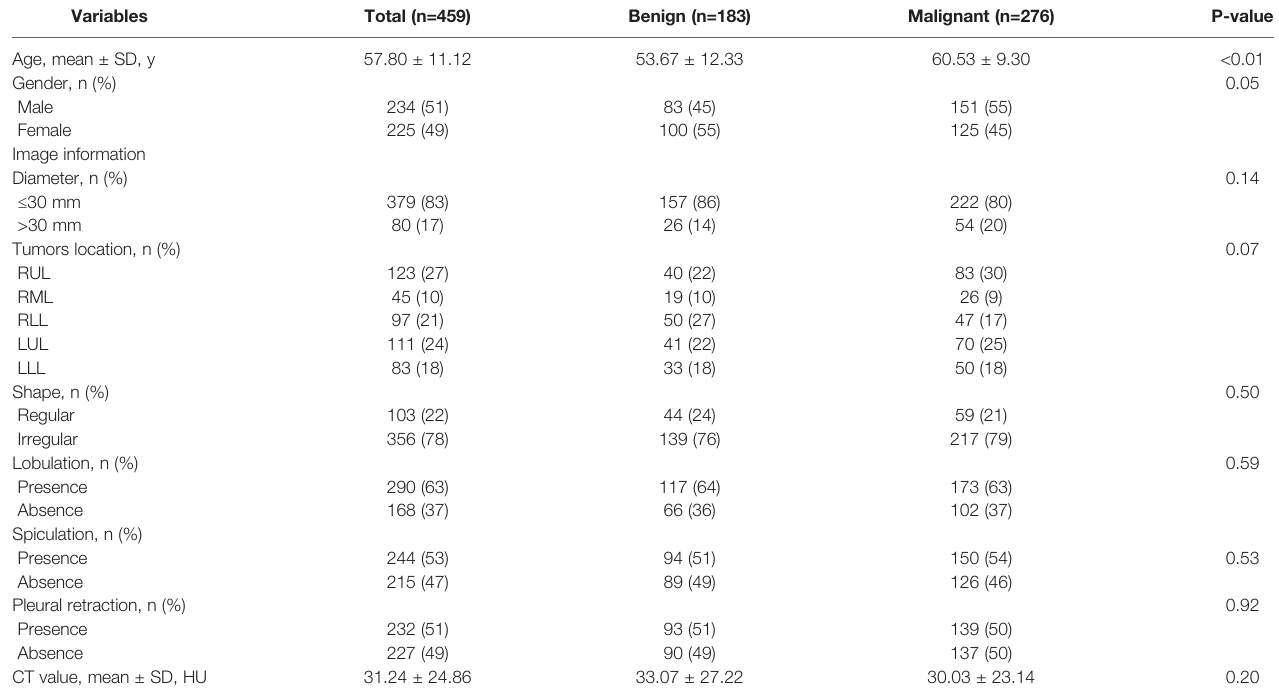
The data are expressesed as mean ± standard deviations for continuous variables, and the frequency and percentage for categorical variables. A p-value < 0.05 was supported to be statistically signi fi